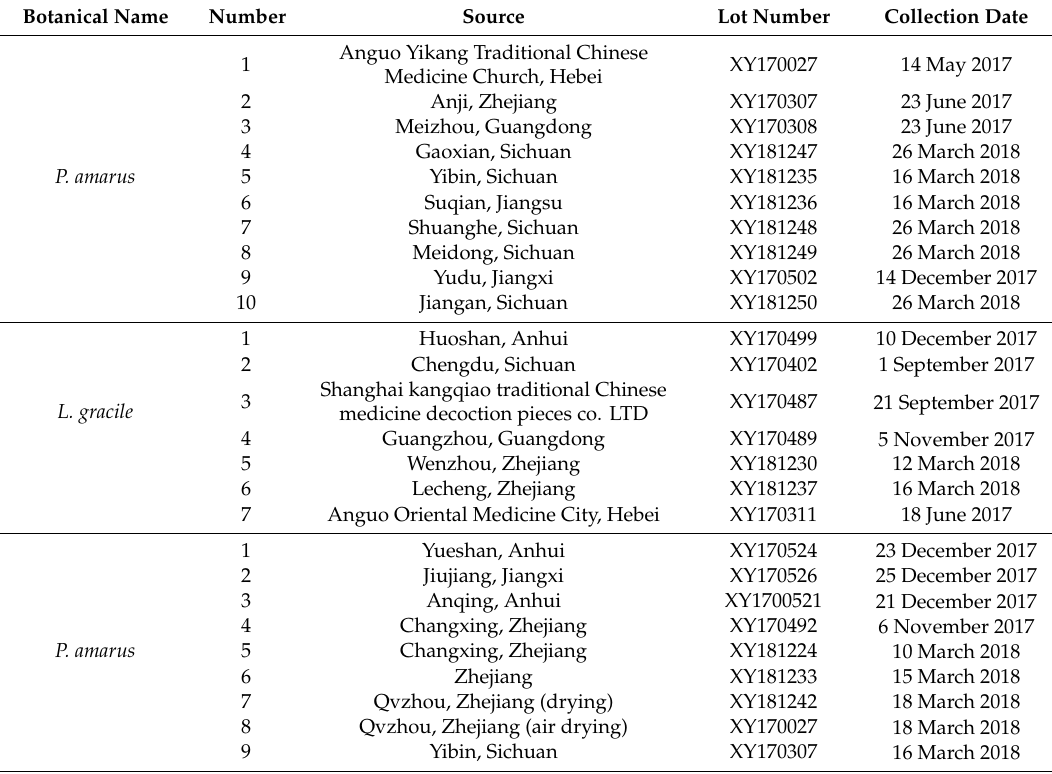
Table 7. Information sheet of twenty-six commercial herbal